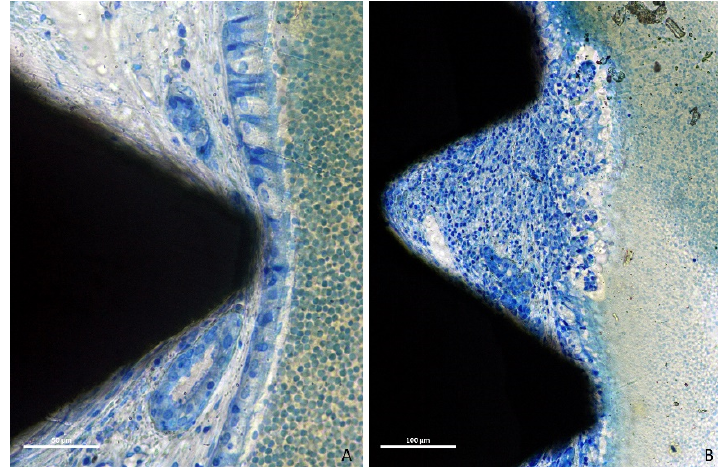
Figure 10. Photomicrographs of ground sections. ( A , B ), inflammatory infiltrates within the sinus concomitant to various degree of degeneration in the sinus mucosa were rarely found. ( A , B ), Stevenel’s blue and Alizarin red stain.